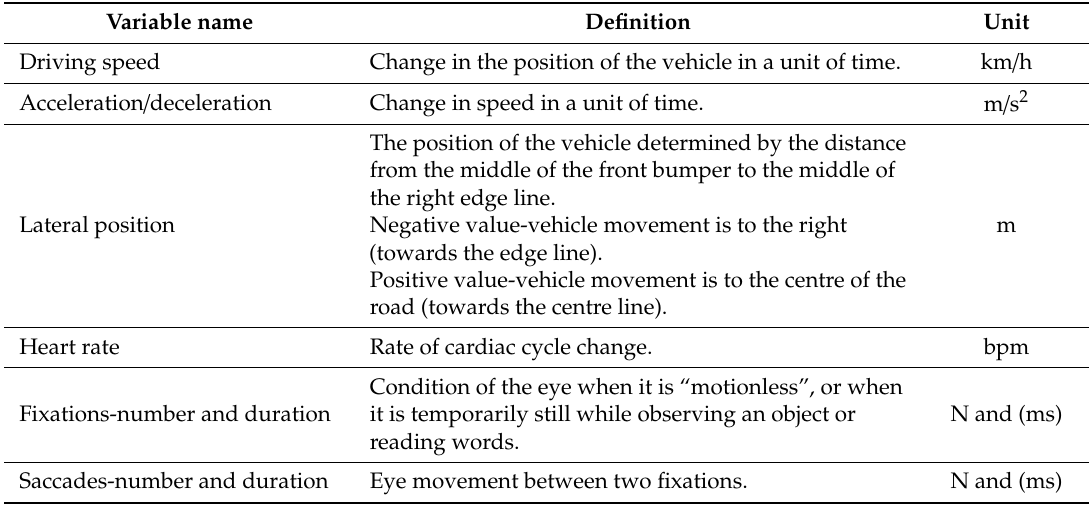
Table 1. Names, definitions and units of the